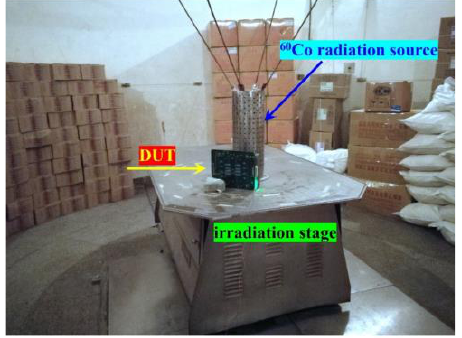
Figure 2. DUT in the terminal of the 60 Co irradiation.